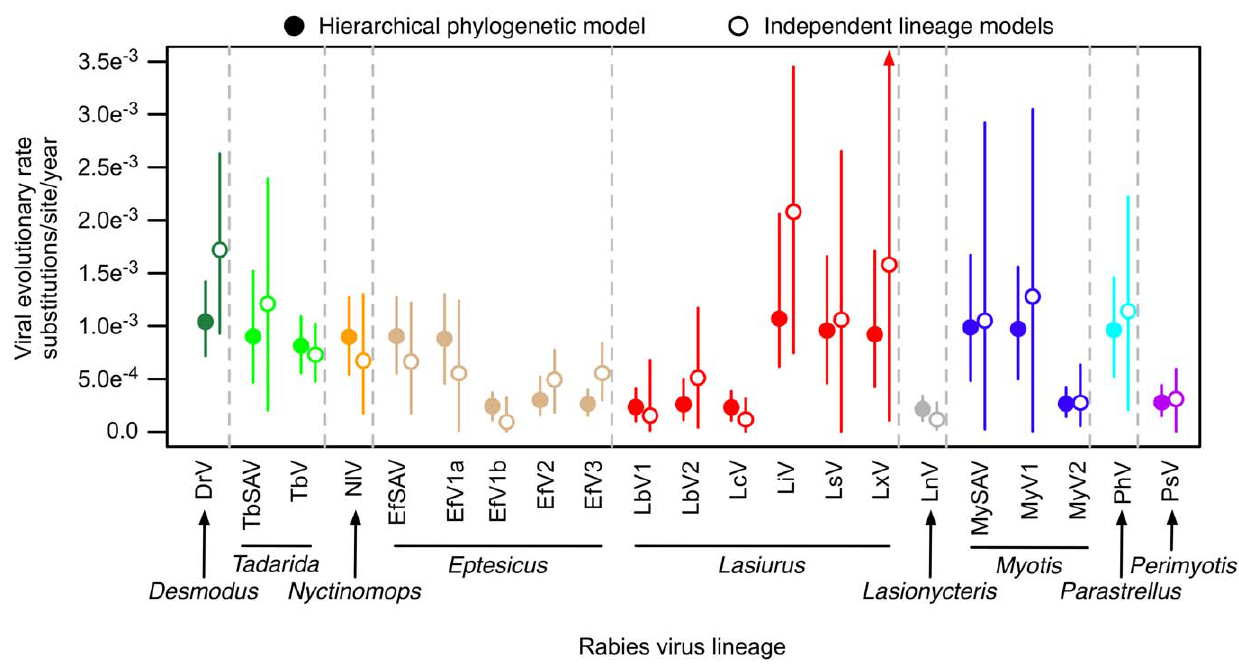
Figure 1. Heterogeneity in evolutionary rates of host-associated bat rabies viruses. Median substitutions per site per year in the 3 rd codon position of the nucleoprotein gene for estimates generated by the HPM (filled circles) and ILMs (open circles). Colors and dashed gray lines distinguish bat genera as indicated below the x-axis. Credible intervals denote the 95% highest posterior density interval on evolutionary rate.